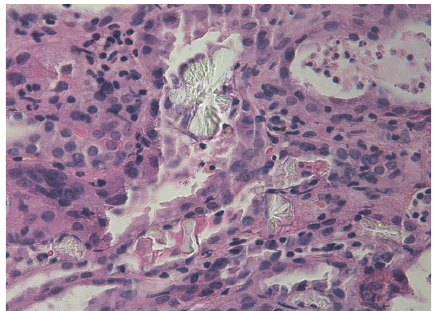
Figure 2: Light microscopy (H&E × 400) demonstrates deposition of doubly refractile oxalate crystals in the tubules.